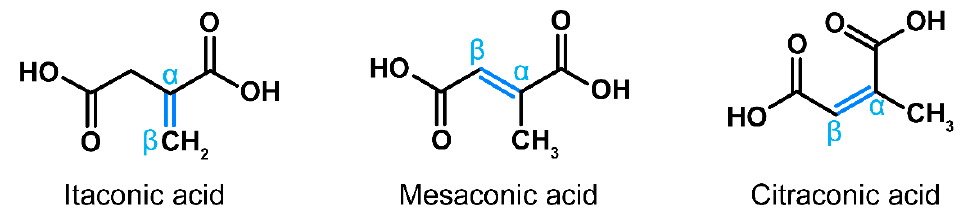
Figure 1. Structures of itaconic, mesaconic and citraconic acids. The isomers differ only by the arrangement of the internal double bond (marked blue), which is an important determinant of electrophilicity and antioxidative potential.